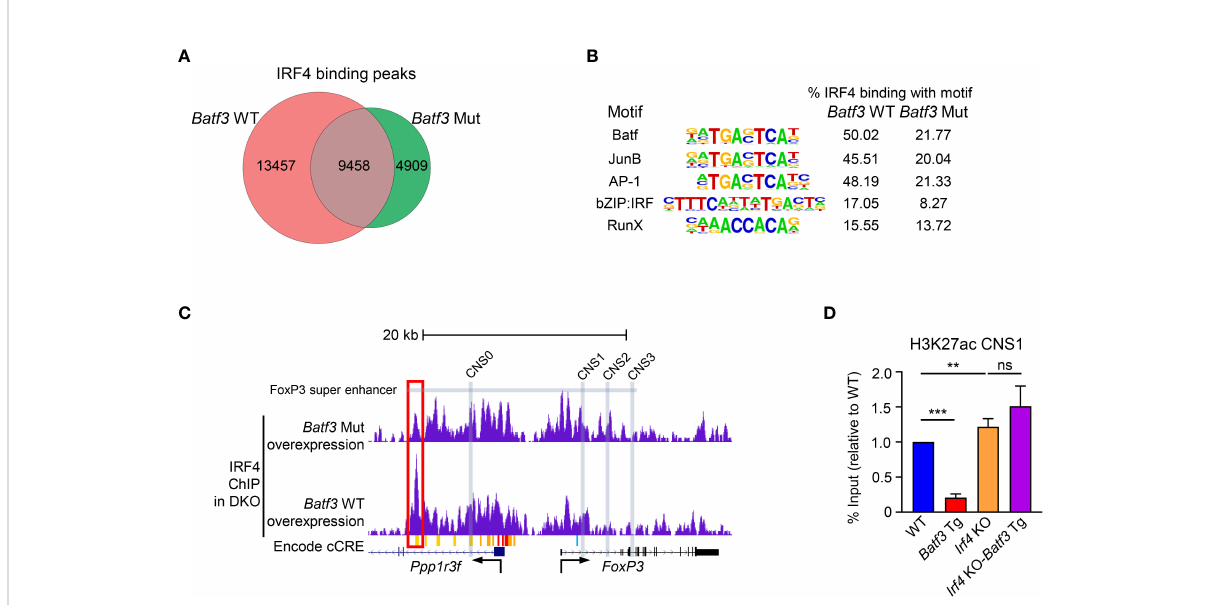
FIGURE 3 IRF4 ChIP-seq and H3K27ac ChIP-qPCR. (A – C) : Naïve DKO CD4+ T cells were activated overnight in T 0 conditions before transduction with Batf3 WT or Batf3 Mut viruses. Transduced cells were cultured in iTreg media for 24 hrs before collection, sorting for virus + cells, and then fi xing for ChIP-seq of IRF4. (A) Number of unique IRF4 binding peaks in cells transduced with Batf3 WT or Batf3 Mut. (B) IRF4 binding motifs in Batf3 WT and Batf3 Mut transduced cells. (C) IRF4 binding in the Foxp3 super enhancer and locus. Differential IRF4 binding peak marked with red box. Super enhancer as de fi ned by Kitagawa et al. Encode cCREs as displayed in UCSC browser. CNS0-3 marked with gray boxes. (D) Naïve CD4+ T cells were activated and differentiated in iTreg inducing media for 48 hrs before ChIP-qPCR for H3K27ac of CNS1 of the Foxp3 locus. Data expressed as mean and S.D. of % input normalized to WT % input of 4 independent experiments. Statistical signi fi cance calculated using unpaired two-tailed Student ’ s T test. **p<0.01, ***p<0.001, ns, not signi fi cant